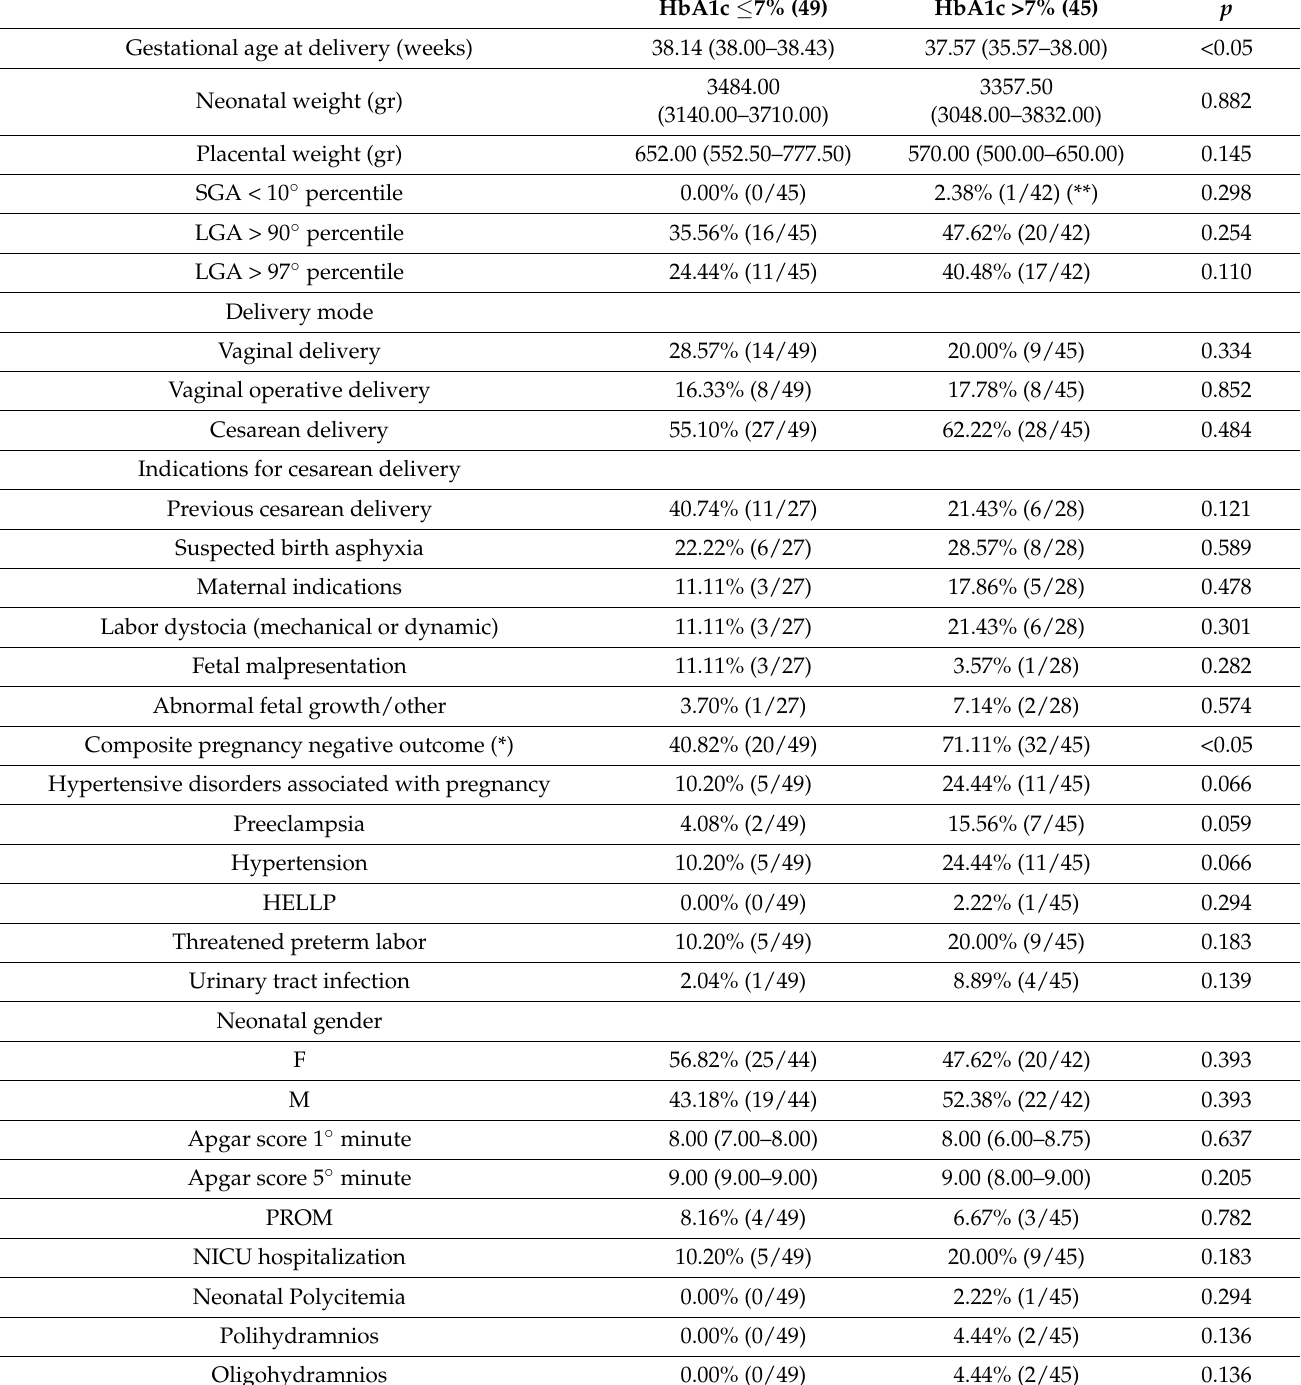
Table 3. Obstetric and neonatal outcomes of patients with pregestational diabetes. Differences between women with HbA1c ≤ 7% and women with HbA1c